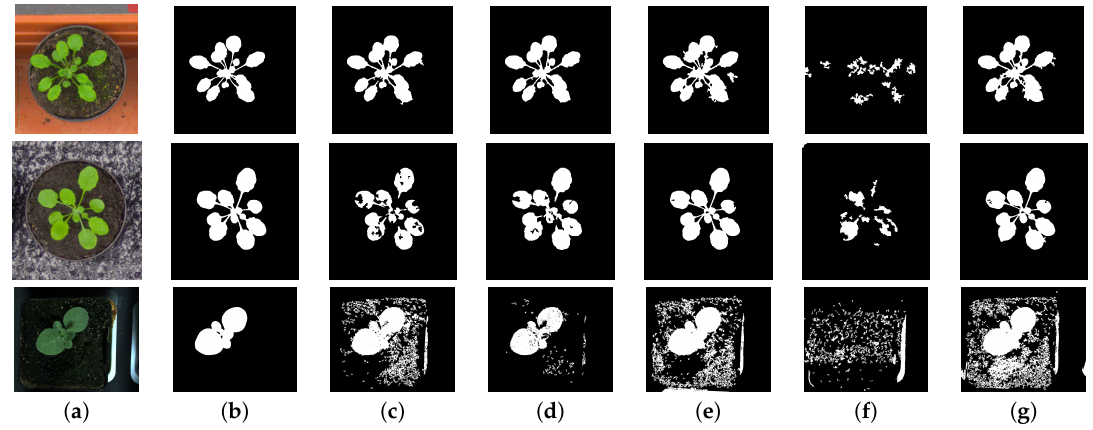
Figure 2. This figure shows the results of segmentation using the method of mean-shift clustering, used in the paper, for different colour spaces. Image in column ( a ) are the original images of Arabidopsis and Tobacco plants. One set of Arabidopsis plant has a contrasting red background and the other has black background. The images in column ( b ) are the ground truth segmentation results. The ground truth segmentation were generated by manual labelling of the image data. In columns ( c – g ) are the segmentation in different colour spaces RGB , HSV , CIE - Lab , normalized rgb , and YCbCr , respectively Table 1. Table for different plant types and the computed Earth Mover Distance (EMD) on the Gaussian Mixture Models (GMM) models in different colour spaces and their comparison with variance ratio in different colour spaces. EMD based distance are higher for HSV on both plant types, where as variance ratios are higher for normalized rgb colour